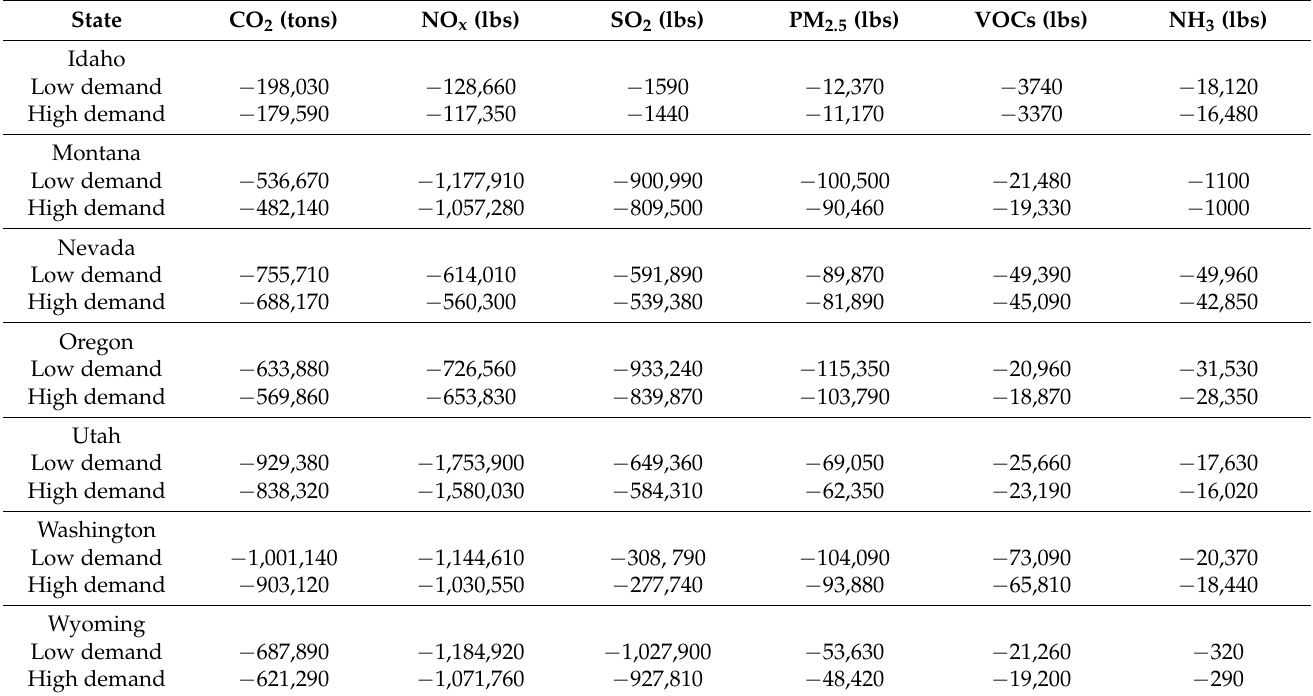
Table 2. Annual state emission changes from the 2019 baseline in the Northwest region, upon RPS 50% in Nevada and under the low- or high-demand scenario by 2030.